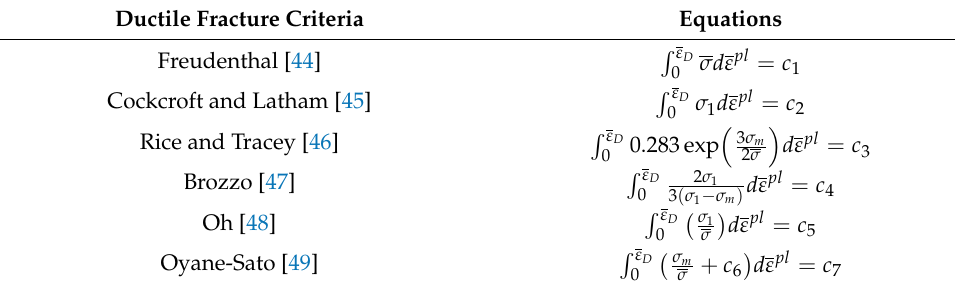
Table 3. Summary of ductile fracture criteria used in the